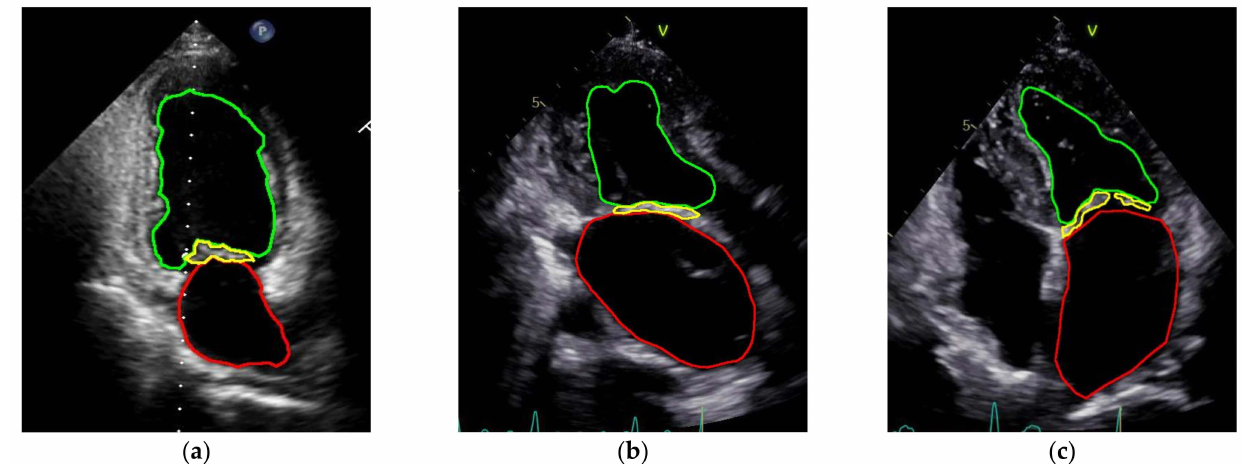
Figure 1. Typical echocardiographic images and labeling ( a ) labeling of two apical chambers; ( b ) apex three lumen labeling; ( c ) apical four-chamber